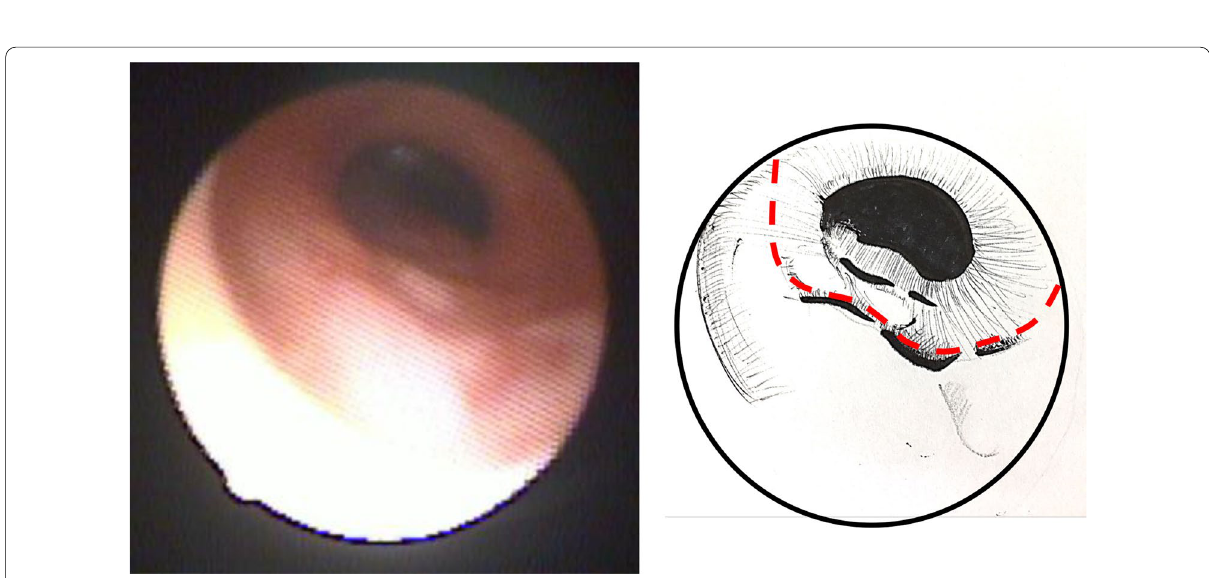
Fig. 6 Bronchoscopy at 8 months of age showed no granulation at the site of anastomosis (red dotted